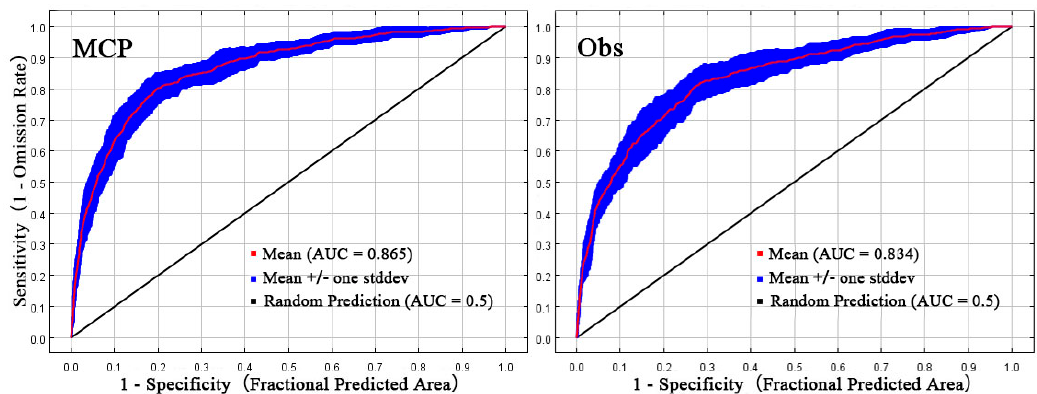
Figure 6. ROC curve verification of the predicted potential habitat for Spodoptera frugiperda by MaxEnt.